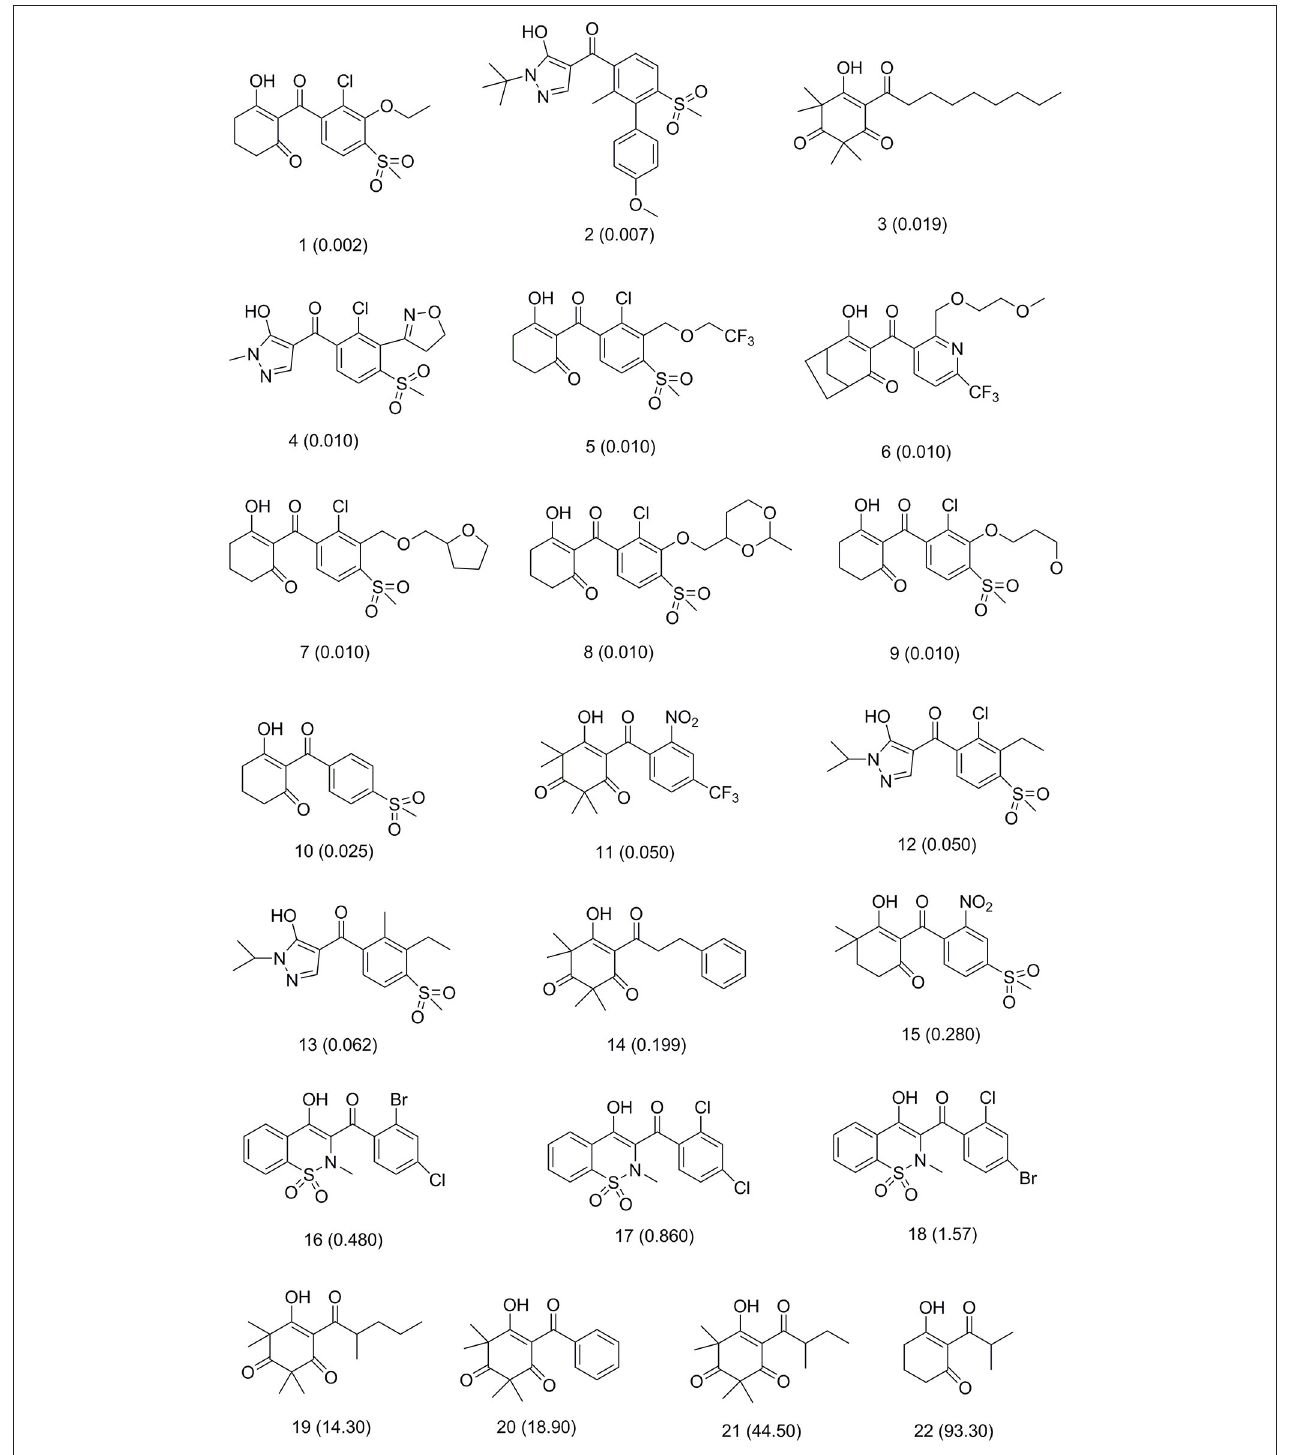
FIGURE 3 | Test set compounds with IC 50 values used for pharmacophore model validation.